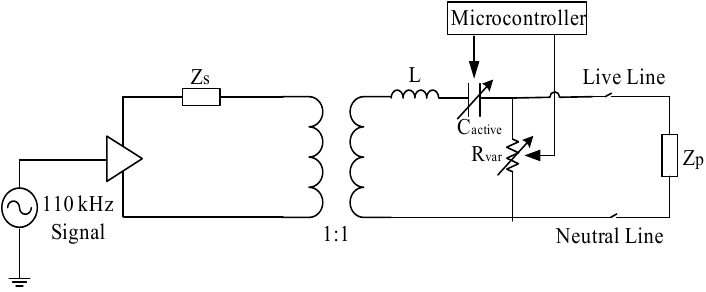
Figure 4. RLC bandpass adaptive impedance matching circuit [75].